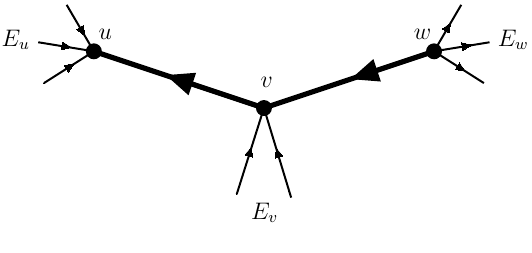
Fig. 5: An orientation D of a graph G with an induced 2 -path